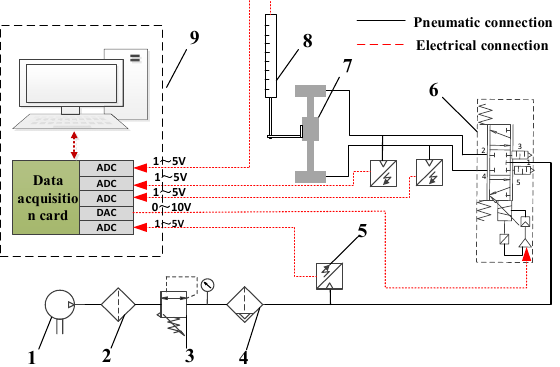
Figure 1. Schematic of the servo control system for the position of the magnetically even rodless cylinder (1—air compressor; 2—air filter; 3—air regulator; 4—air lubricator; 5—pressure transmitter; 6—proportional directional control valve; 7—magnetically coupled rodless cylinder; 8— pull-rod displacement sensor; 9—IPC).